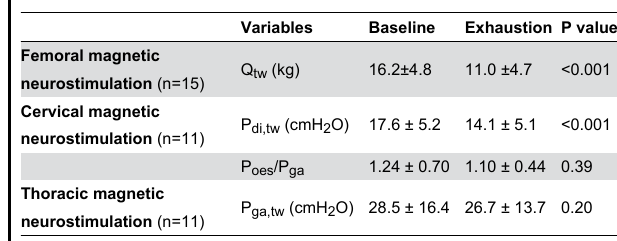
Table 4. Quadriceps and respiratory muscle responses evoked by femoral, cervical and thoracic magnetic stimulation, respectively, before (Baseline) and immediately after exhaustive constant-load cycling.